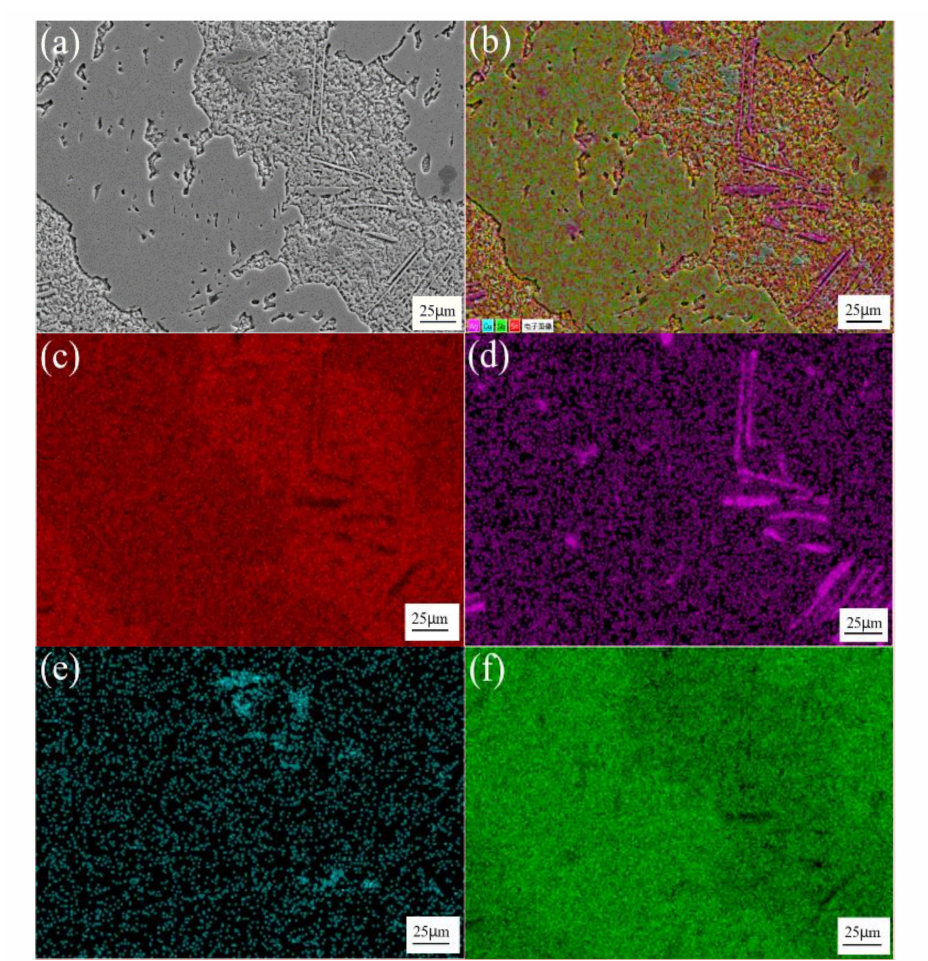
Figure 4. SEM image at 500x of Sn-3.0Ag-0.5Cu-25Sb ( a ); combined elemental map ( b ); and element distribution maps of Sn ( c ), Ag ( d ), Cu ( e ), and Sb ( f ).